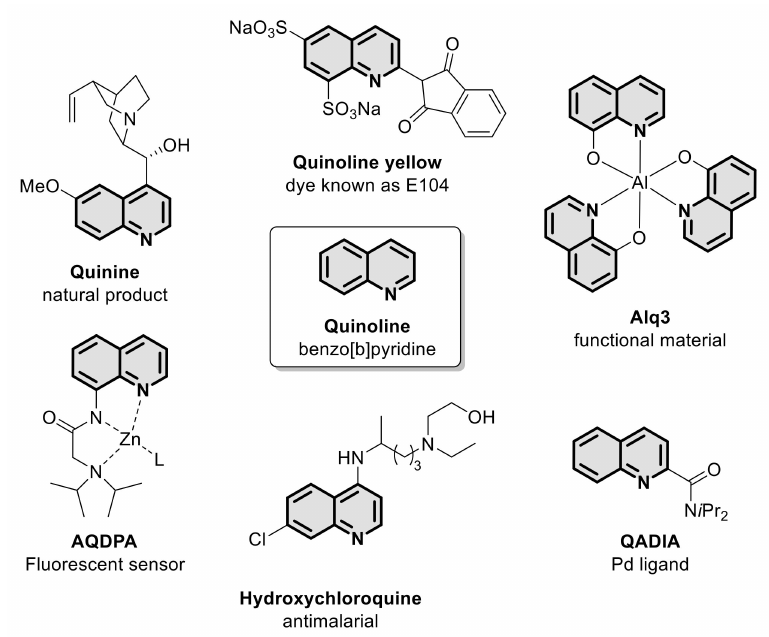
Figure 1. Quinoline scaffold and illustrative examples of significant quinoline derivatives.